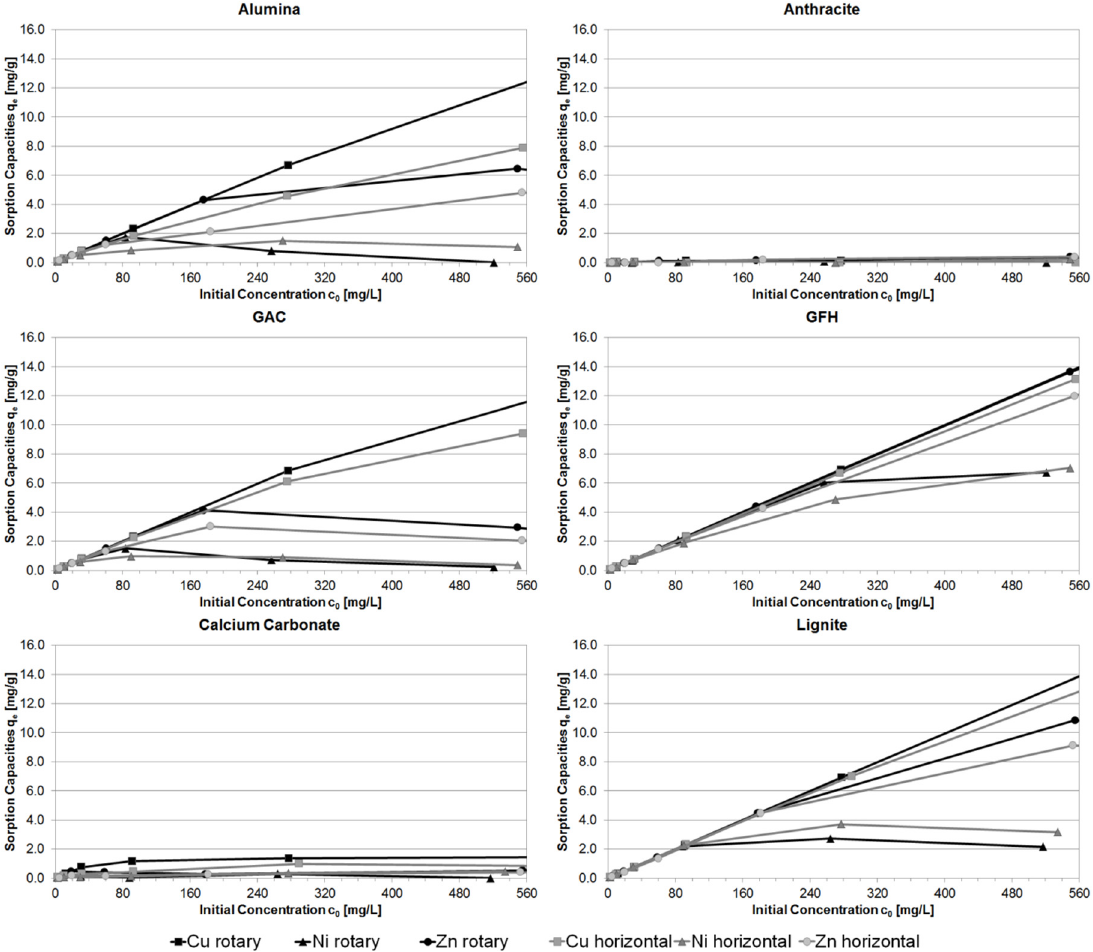
Figure 1. Influences of a rotary shaker (16 rpm) and a horizontal shaker (125 rpm) on sorption capacities at pH 5 without a buffer.